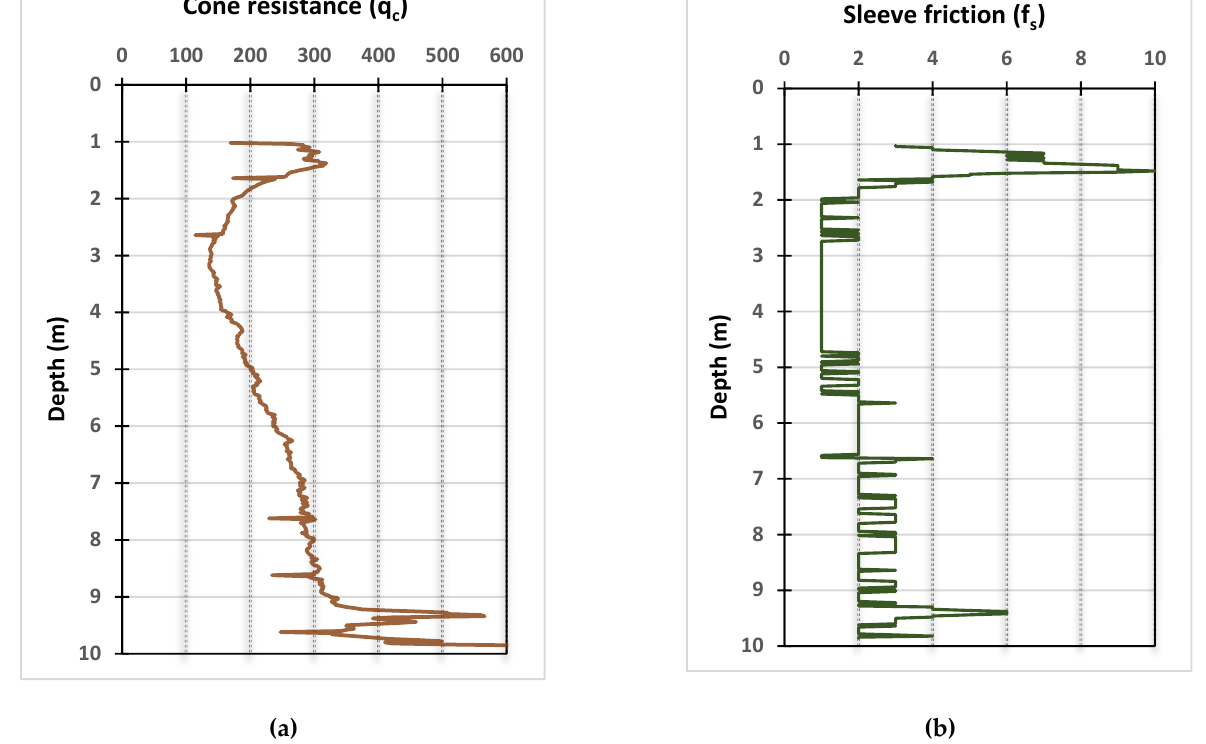
c ; ( b ) Sleeve friction, f s [46].